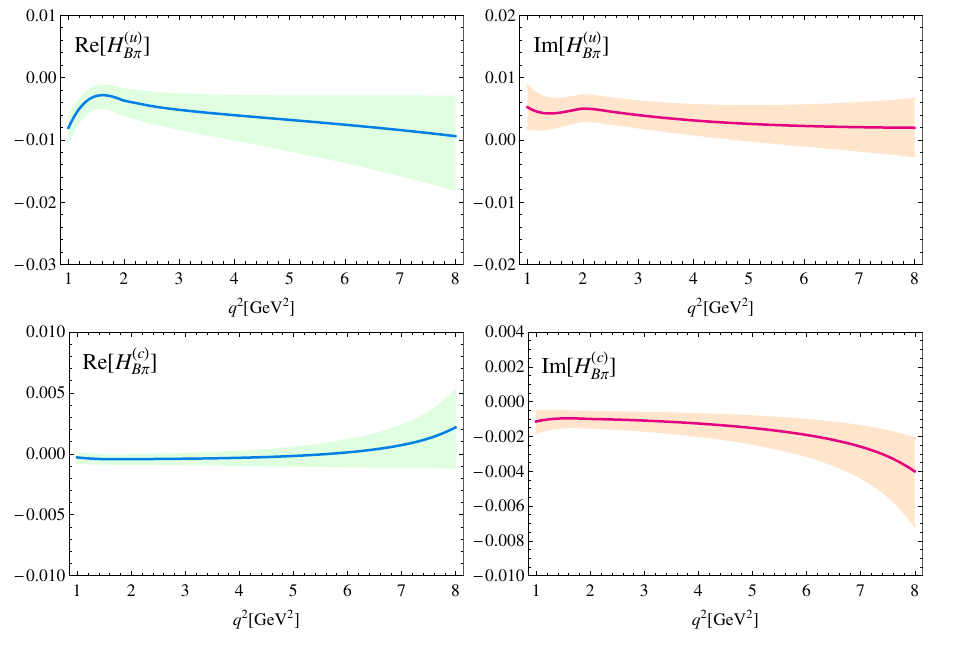
Figure 3 . The same as in (cid:12)gure 2 for the amplitudes H ( u )